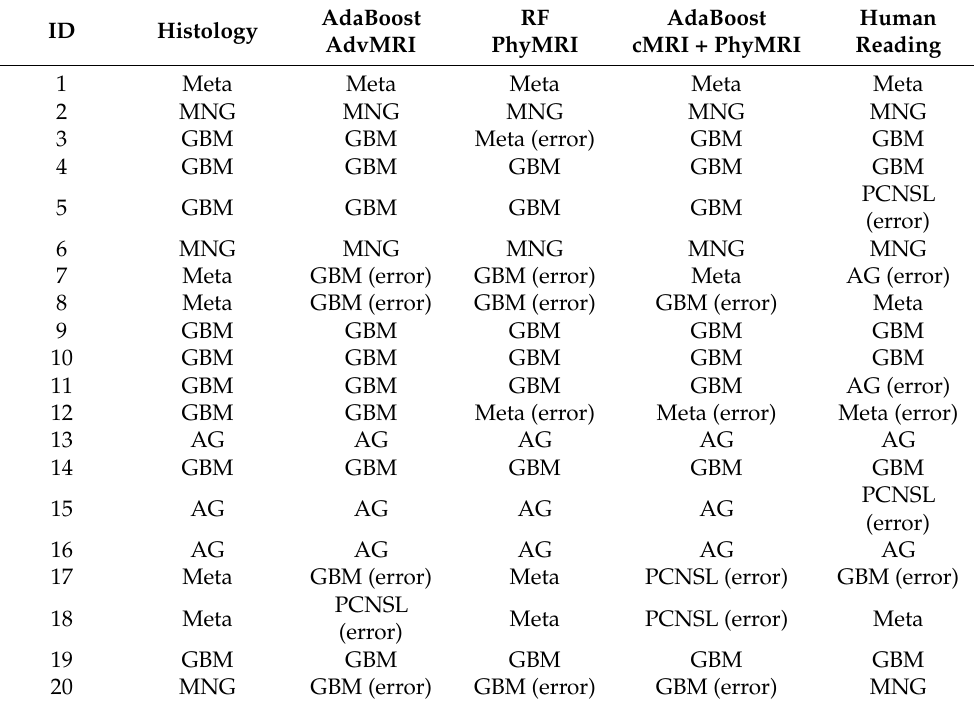
Table 5. Classification results of the best-performing ML models and human reading for the test cohort. AdaBoost ID Histology